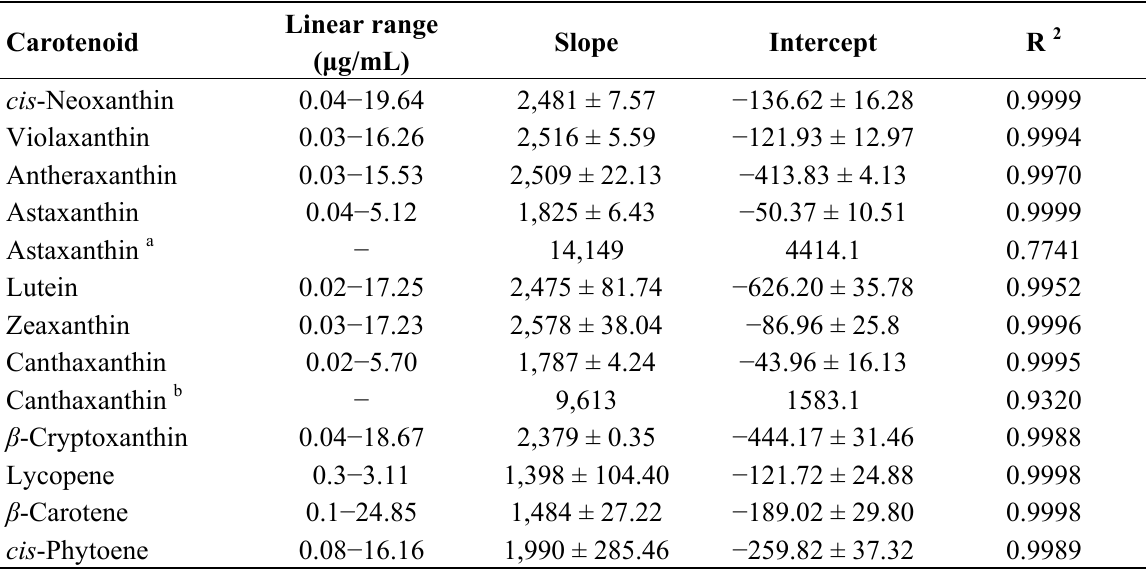
Table 5. Linear regression data obtained for several carotenoid standard curves under UHPLC